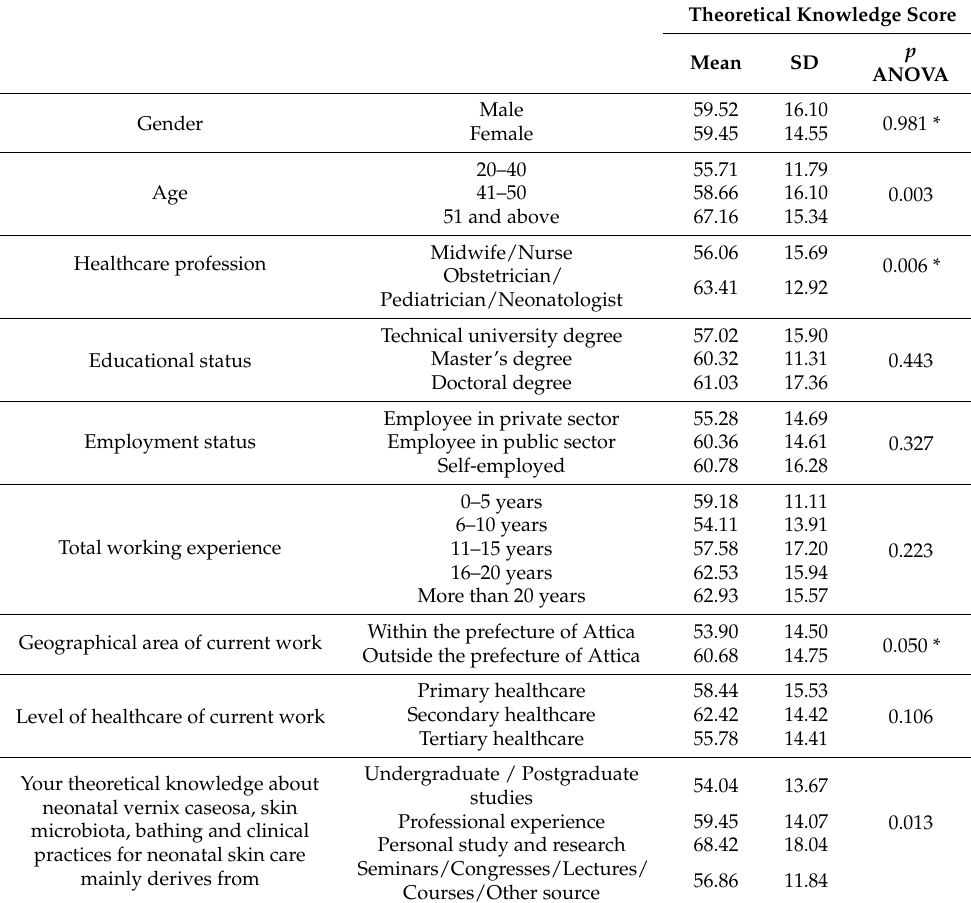
Table 3. Associations among participants’ theoretical knowledge score and demographic and occupa- tional